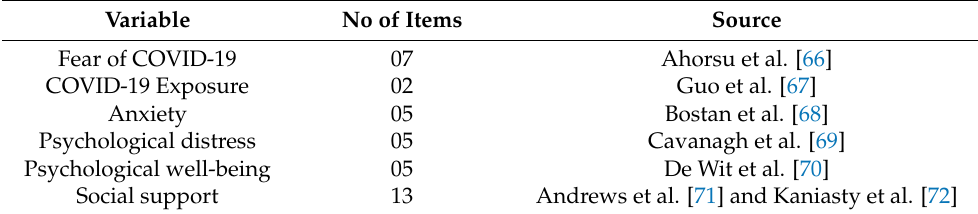
Table 1. Sources of Measurement